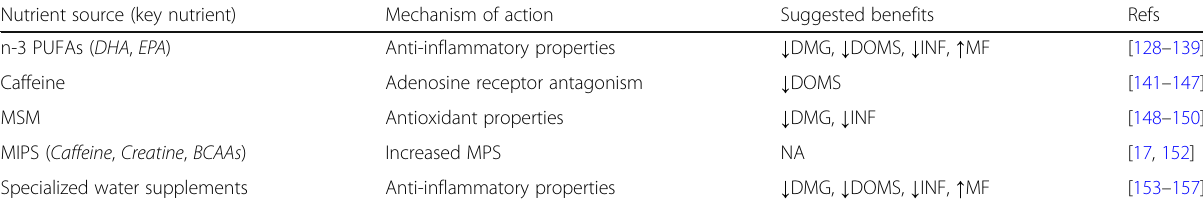
Table 6 Overview of other nutritional supplements Nutrient source (key